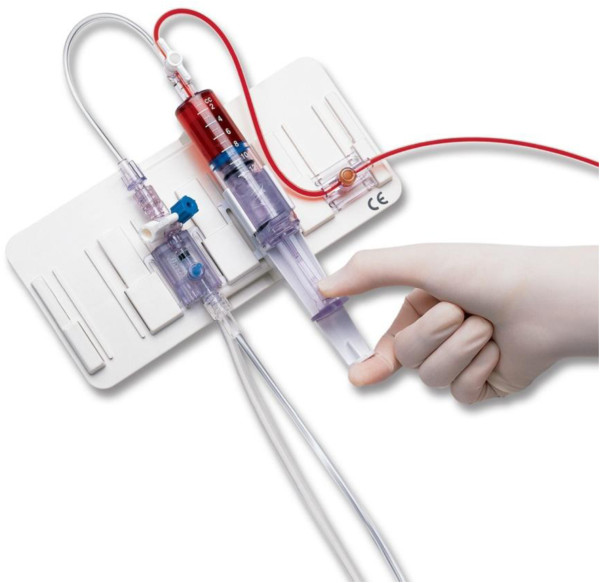
Edwards VAMP system. The port to the right of the image is the sampling port, which is accessed by a needless device. The middle syringe is the reservoir where the previous “discarded” blood is held before being reinfused back into the patient. Picture submitted with permission from Edwards Lifesciences Ltd.